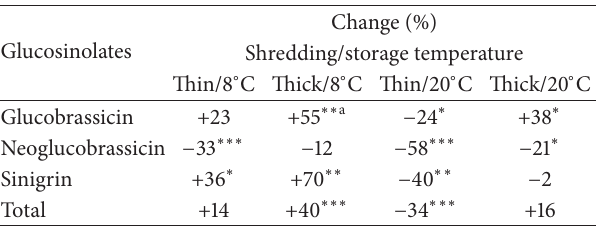
Table 2: Effects of mechanical damage and measurement time on GLS content e in shredded cabbage after storage at 20 ∘ C. Glucosinolates ( 𝜇 mol kg −1 FW) Glucobrassicin Neoglucobrassicin Sinigrin Gluconasturtiin Glucobrassicanapin 4-Hydroxy-glucobrassicin Glucoalyssin Progoitrin Gluconapin Gluconapoleiferin